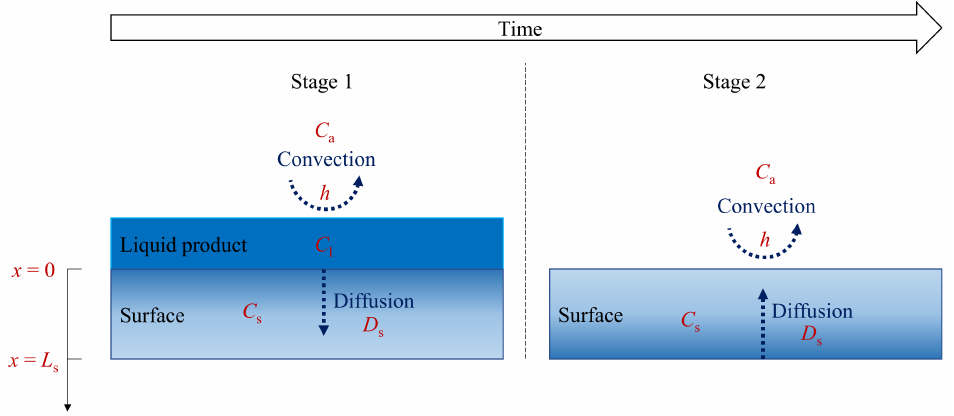
Figure 1. Schematic representation of the model to predict the primary emission of chemicals associated with the use of a liquid